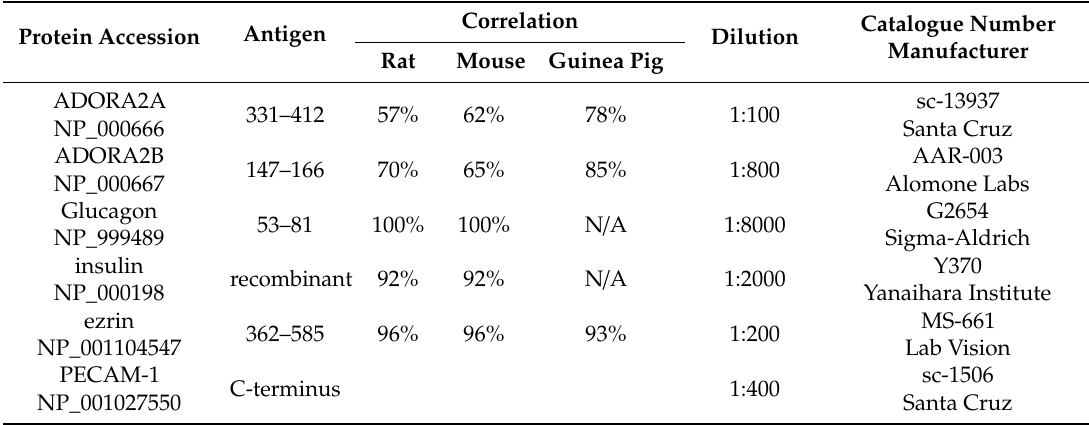
Table 1. Antibodies used in